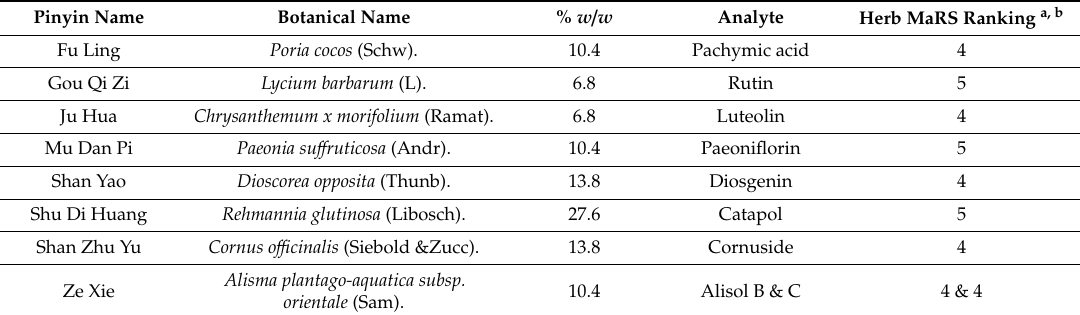
Table 2. The constituent herbs and analytes in QJDHW.